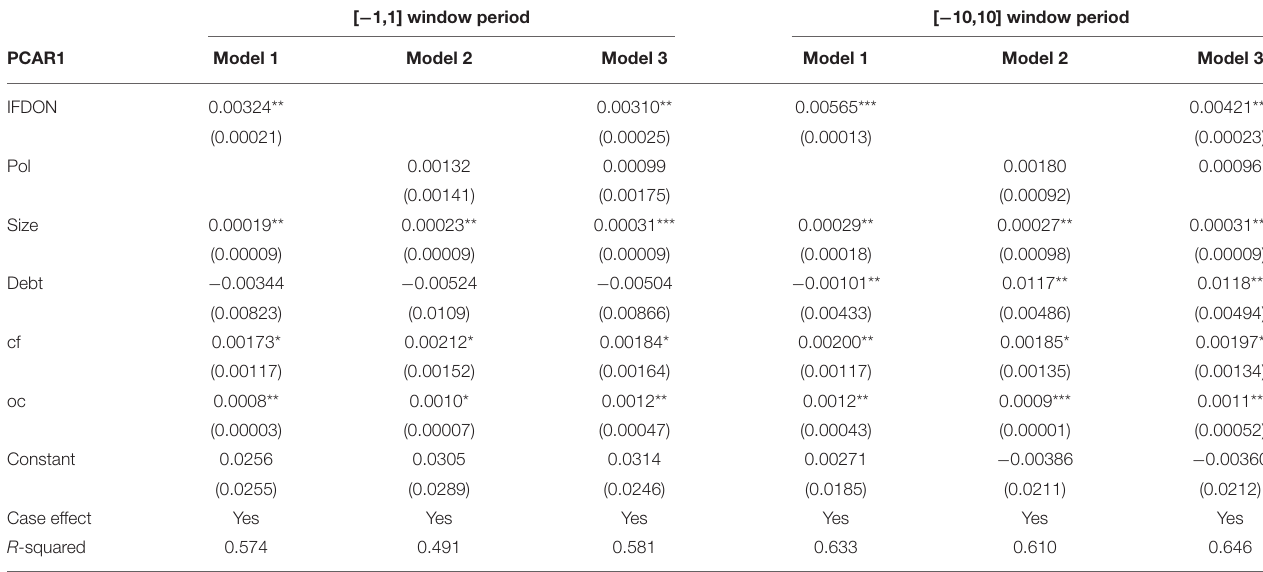
TABLE 6 | The results of regression analysis of [ − 1,1] and [ − 10,10] window